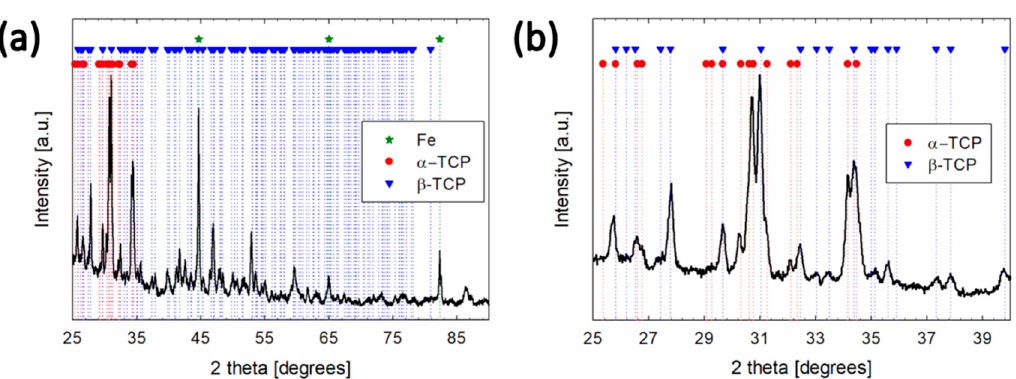
Figure 2. X ‐ ray diffraction (XRD) pattern of ( a ) the tricalcium phosphate–iron (TCP–Fe) composite surface after spark plasma sintering at 1100 °C and ( b ) detail of the pattern showed in ( a ) in the 2 ‐ theta range between 25 and 40 degrees.